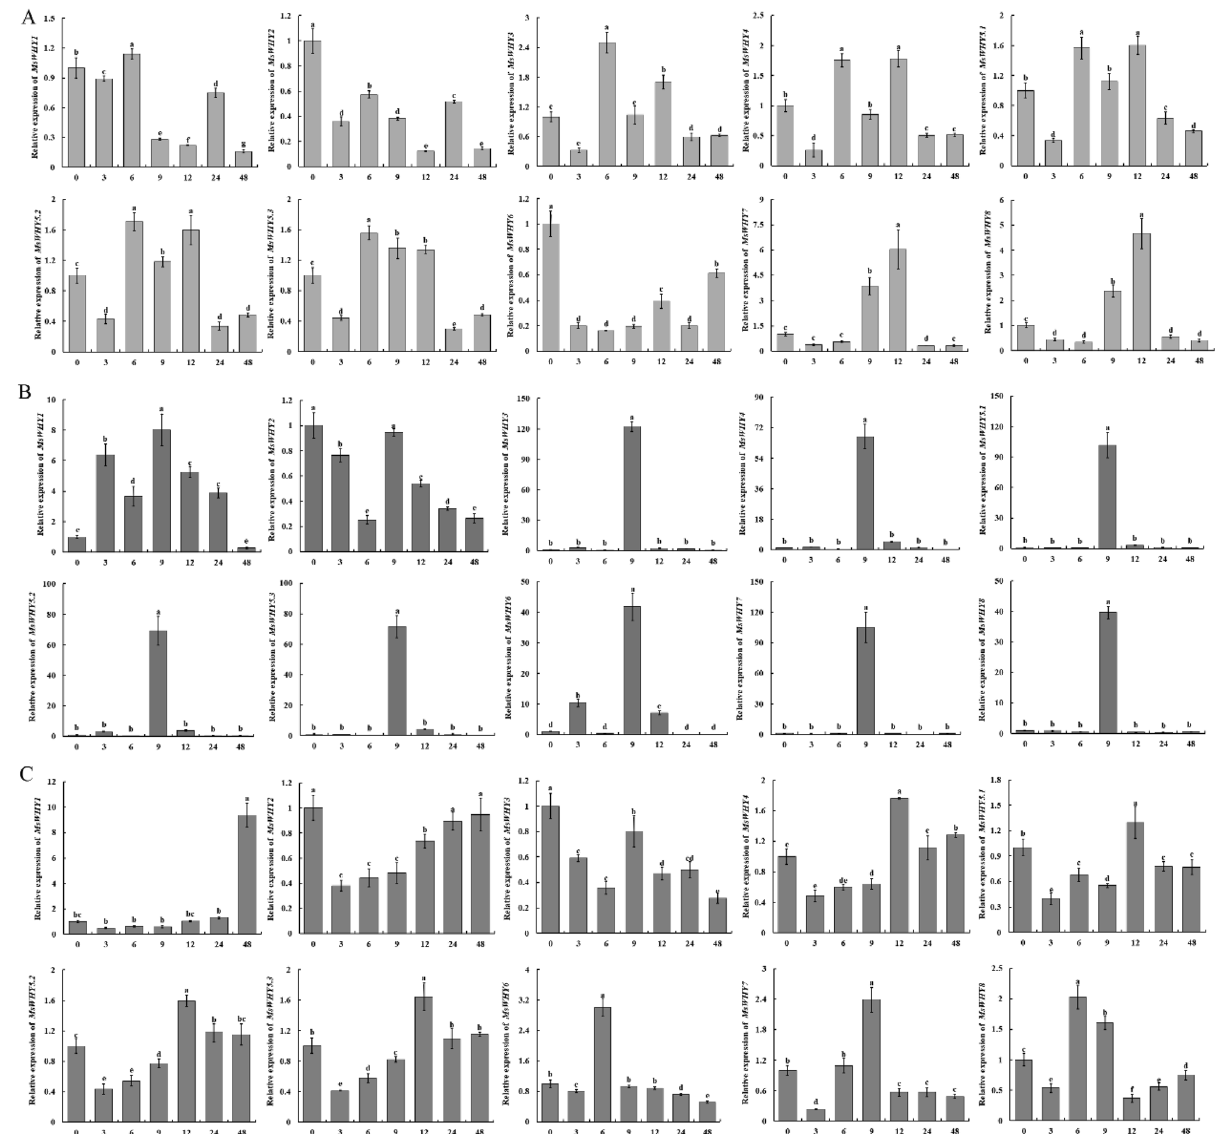
Figure 8. qRT-PCR expression analysis of MsWHY genes. Treatment time: 0 h, 3 h, 6 h, 9 h, 12 h, 24 h, and 48 h. ( A ): Expression analysis of MsWHY genes under PEG stress; ( B ): Expression analysis of MsWHY genes under NaCl stress. ( C ): Expression analysis of MsWHY genes under MeJA treatment. Error bars represent standard errors of three biological replicates. The different lowercase letters indicate significant differences at the P < 0.05